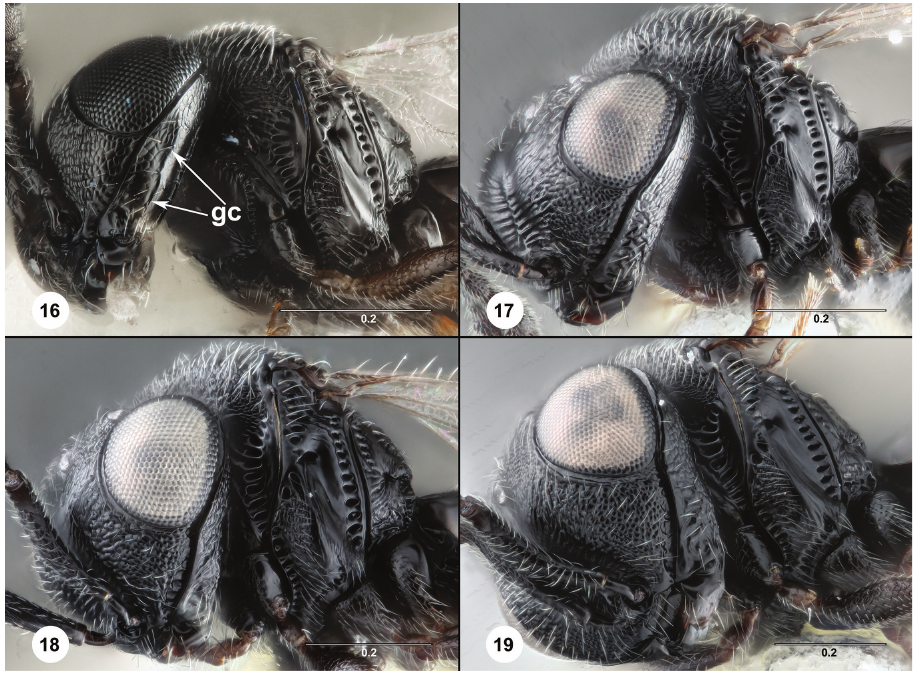
Figures 16–19. Trissolcus utahensis , head and mesosoma, ventrolateral view 16 DPI_FSCA00033239 (ex. B. hilaris ) 17 FSCA 00033041 (ex. P. maculiventris ) 18 FSCA 00000302 (ex. P. maculiventris ) 19 FSCA 00033040 (e. P. maculiventris ). Scale bars in